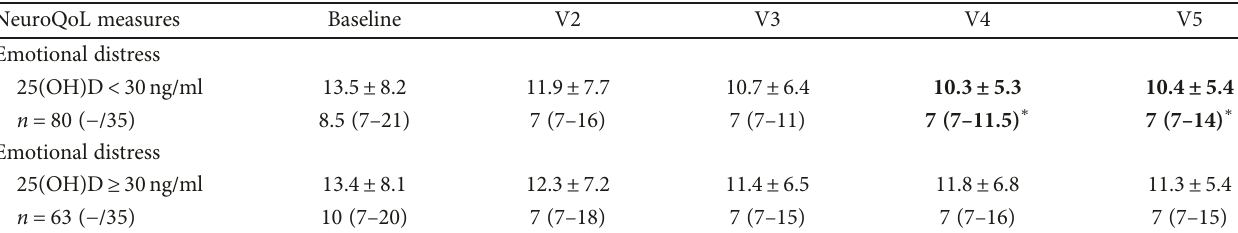
Table 4: Response in emotional distress strati fi ed according to baseline vitamin D status ( < 30ng/ml and ≥